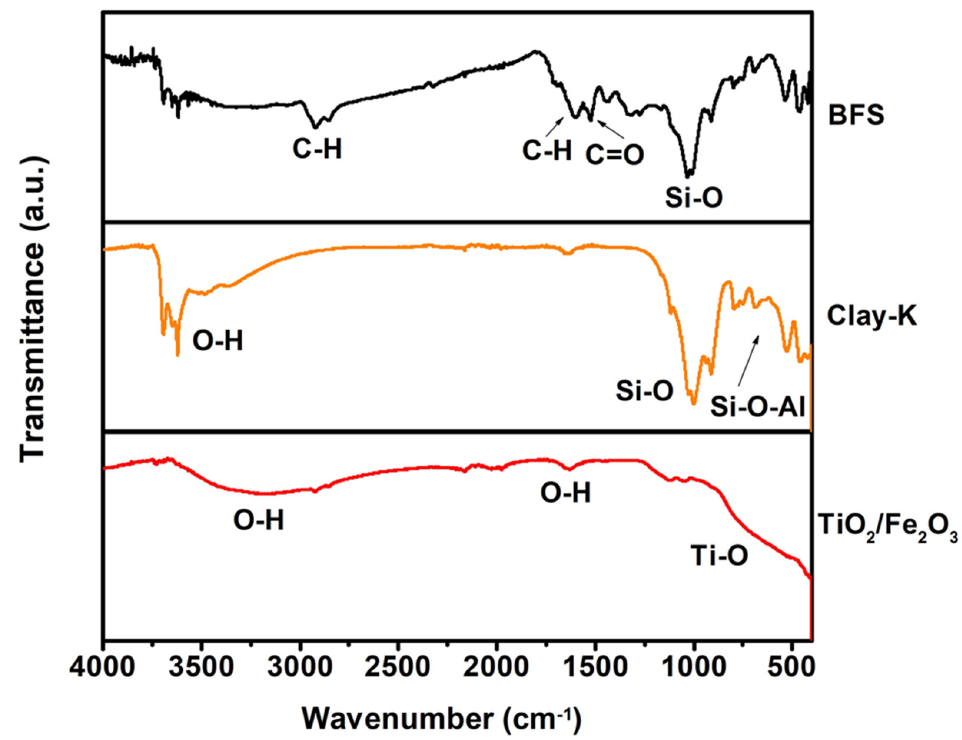
Figure 3. FTIR-ATR spectra of BFS, Clay-K, and TiO 2 /Fe 2 O 3 samples.